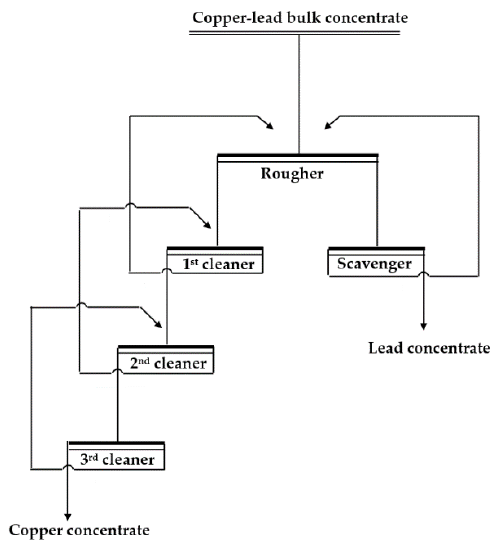
Figure 3. Flowsheet of the batch locked-cycle tests.